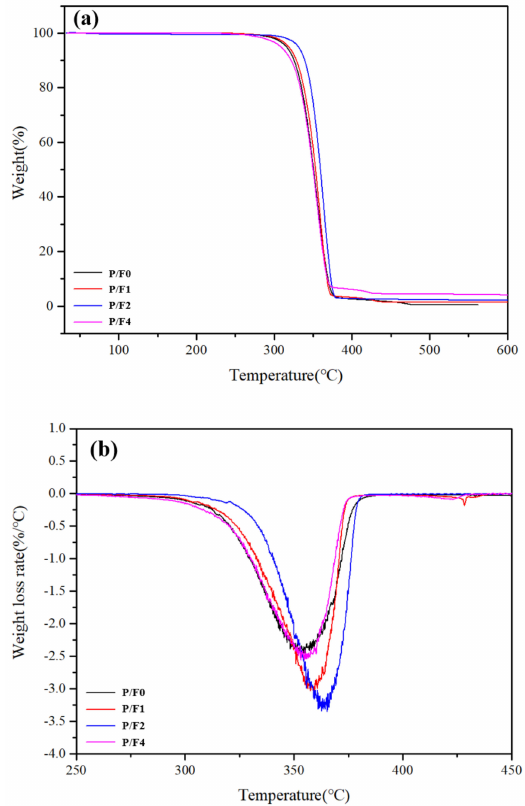
Figure 10. TGA ( a ) and DTG ( b ) of P/F